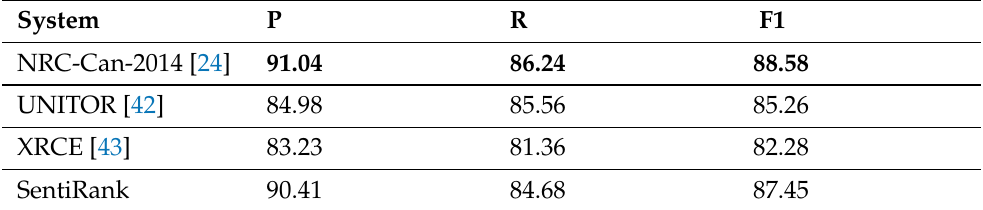
Table 5. Evaluation of the aspect detection module.